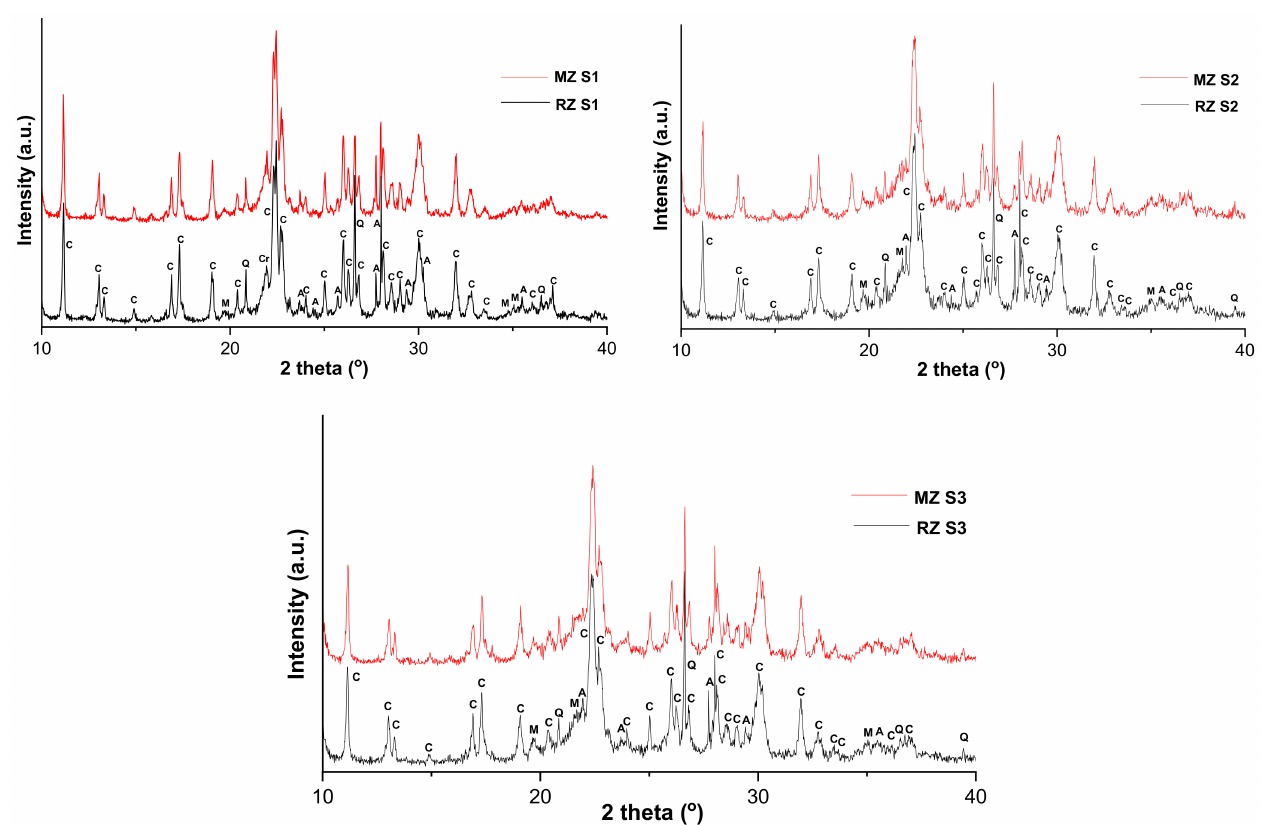
Figure 3. The XRD patterns of RZ and MZ samples (note: clinoptilolite, C; albite, A; muscovite, M; quartz, Q; cristobalite, Cr).